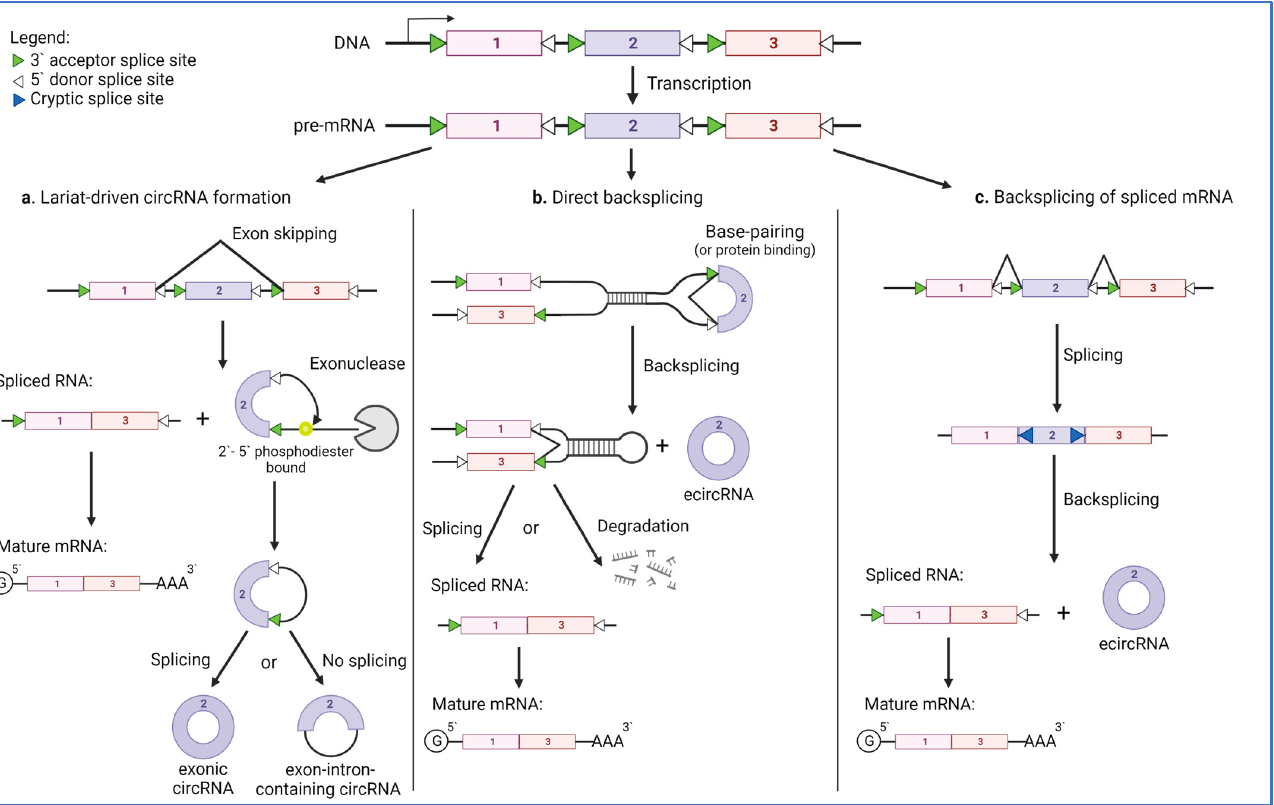
Figure 2. Mechanisms of circRNA biogenesis. CircRNAs can be generated from linear RNAs by three different mechanisms. ( a ) In the lariat-driven process, the pre-mRNA is alternatively spliced by skipping exon 2. This process gives rise to a spliced transcript containing exons 1 and 3 and a circular form of RNA called a lariat. The lariat is generated by RNA branching through a 2 ′ -5 ′ phosphodiester bound. The free RNA end is next digested by an exonuclease. The newly formed circRNA can undergo additional splicing, leading to the excision of the intron and producing an exonic circRNA (ecircRNA), or it could remain as an exon-intron-containing circRNA (EIciRNA). ( b ) In the second mechanism, backsplicing occurs before conventional splicing. In this case, base pairing or the association with RNA-binding proteins brings into close proximity the exon 2-flanking splice sites. The first splicing event forms the circRNA containing exon 2, and the rest of the pre- mRNA can undergo additional splicing or be degraded. ( c ) The third mechanism has been described only in cancer and involves the backsplicing of mature mRNA, which utilizes cryptic splice sites within the mRNA.